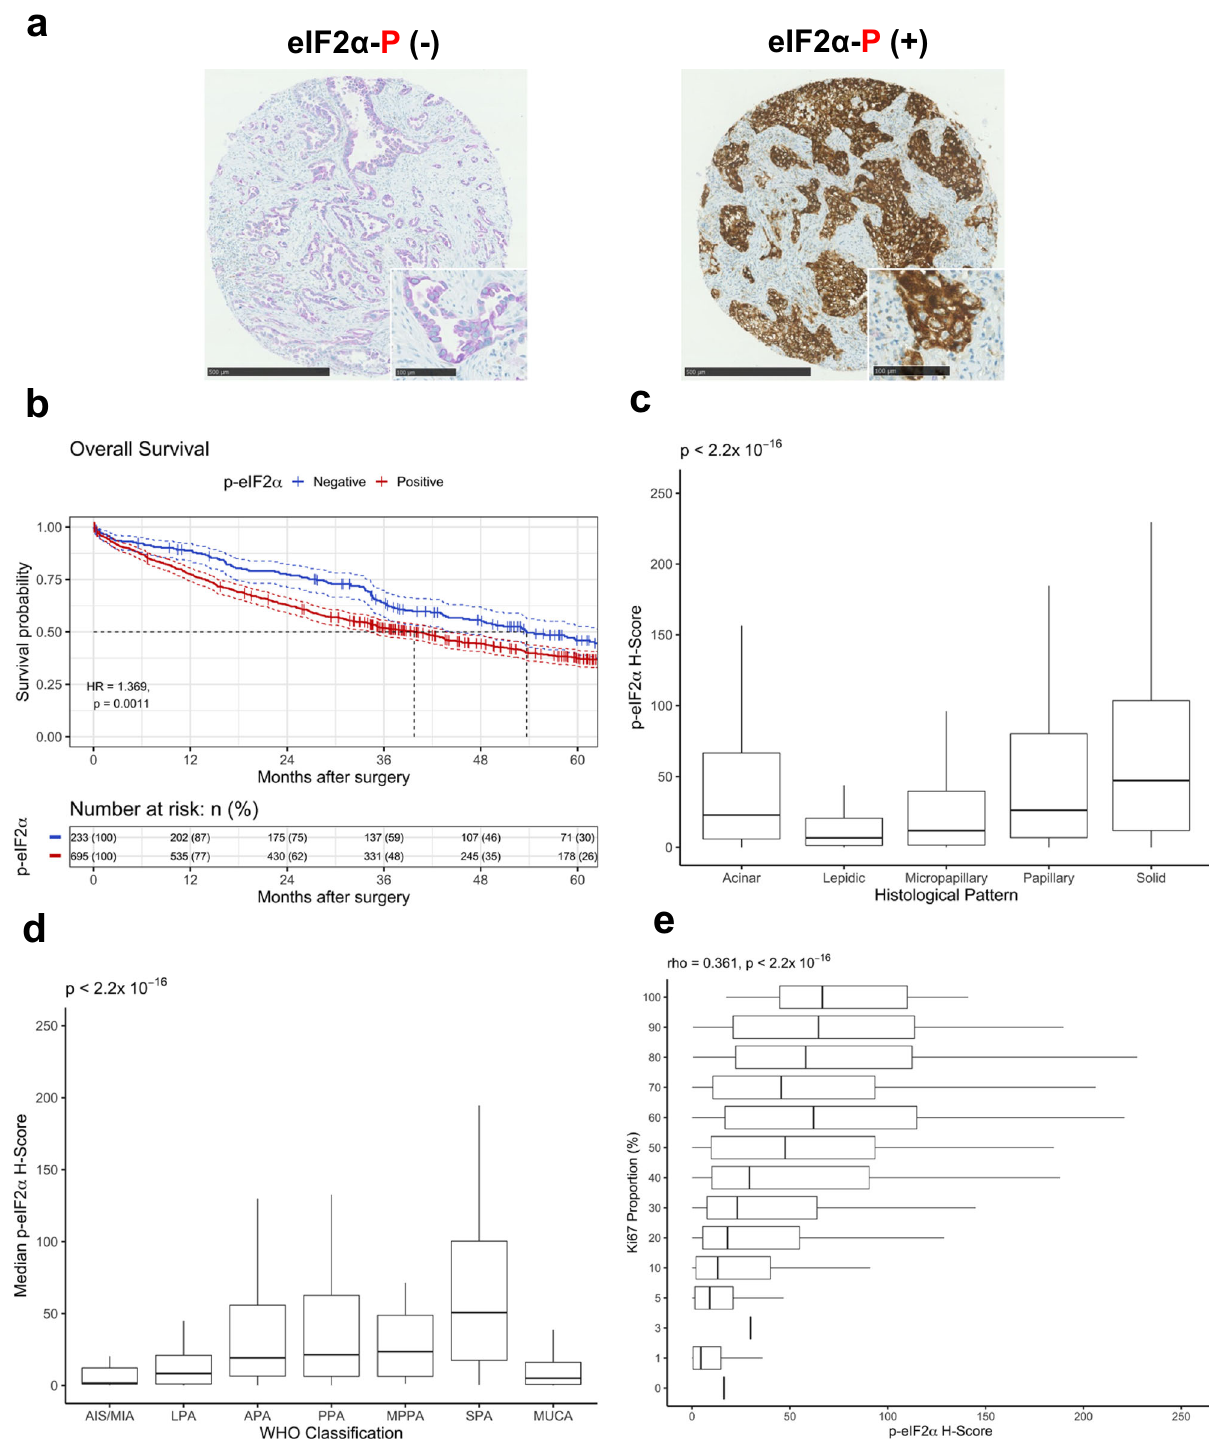
analysis indicated the upregulation of ERK signaling by p-eIF2 α , which plays a major role in KRAS -driven cancer growth 24 . In line with this prediction, immunohistochemical (IHC) analysis revealed higher levels of p-ERK in KRAS G12D eIF2 α S/S than eIF2 α A/A lung tumors regardless of the histological tumor type (Fig. 3a; Supplementary Fig. 2). The direct relationship between p- eIF2 α and p-ERK also became evident in a different mouse lung cancer model, which was driven by KRAS Q61R/L after urethane (ethyl carbamate) treatment 25 . Speci fi cally, lung tumors in